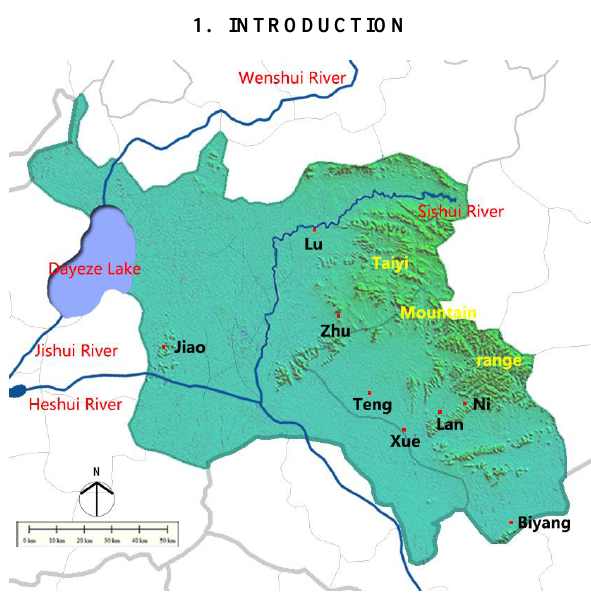
Figure 1. The layout of states during the Spring and Autumn Period and Warring States Period in south region of Shandong In Spring and Autumn period, Weishan Lake was not existent, and the lake bed now was a valley, through where Sishui River flowed into Huaihe River. Without Weishan Lake to obstruct the traffic from west to east, there was a relatively independent geographical unit -- the south region of Shandong, with Dayeze Lake and Nanwanghu Lake formed the west boundary, and Taiyi mountains on the east side (Yuzhen Yang, 2008a; Yongsheng Guo, 1990a). According to Cultural Relics Atlas China (Shandong Volume) (State Administration of Culture Heritage, 2009) and The Distribution Table of Ancient City